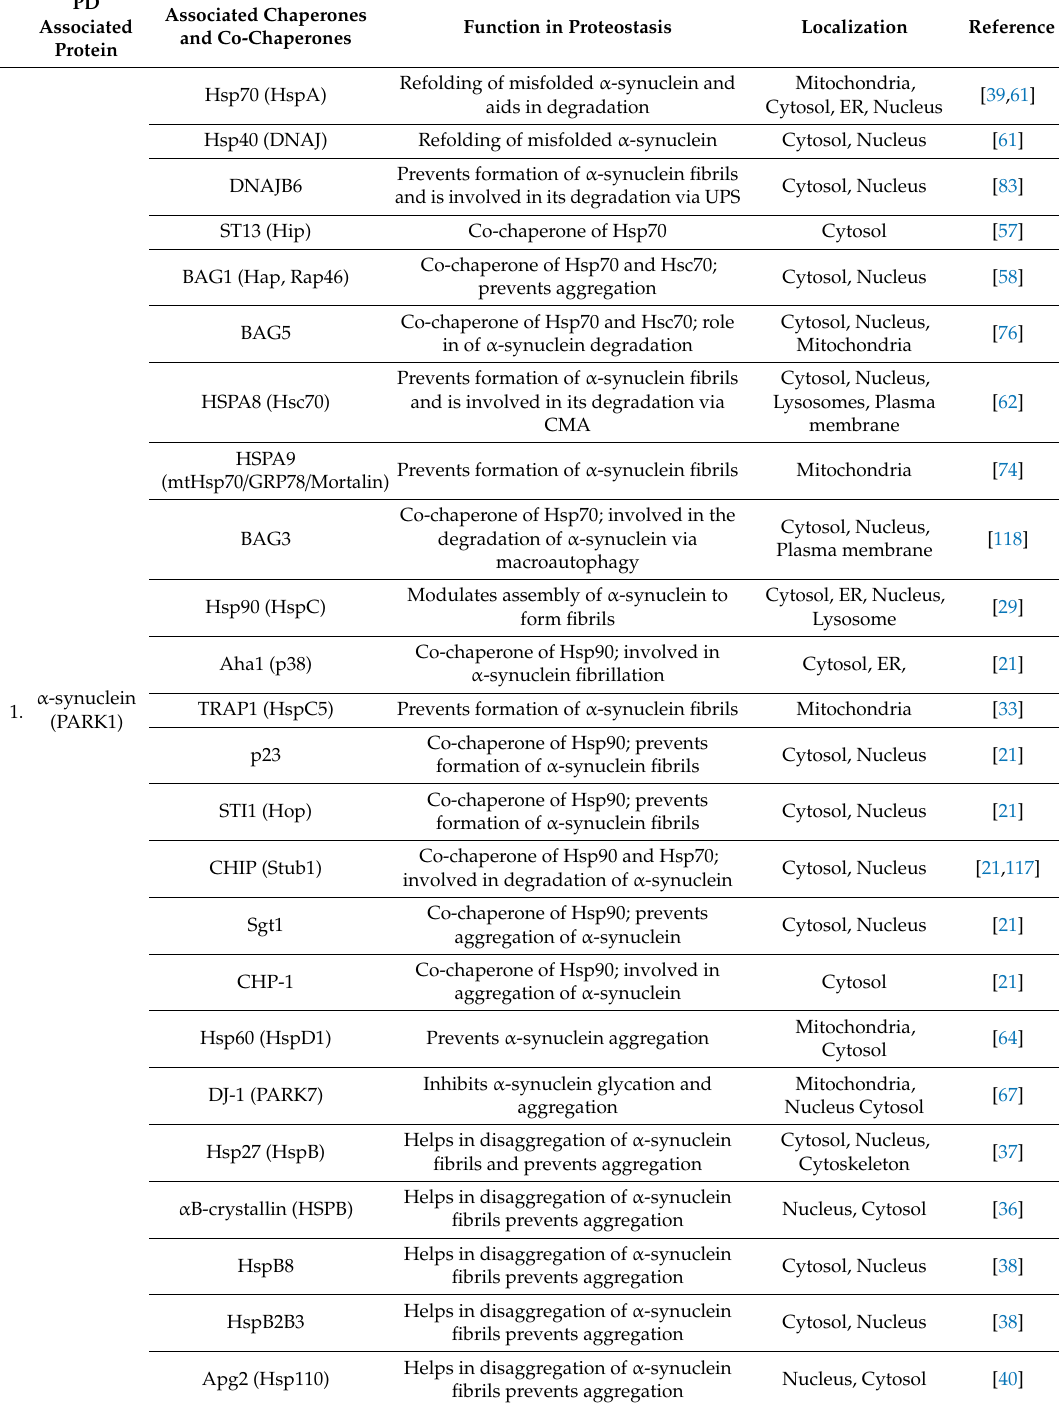
Table 1. Chaperones identified to date that regulate proteostasis of PD-related proteins: The table gives details regarding the cellular localization of the chaperones / co-chaperones and their function in proteostasis of PD related proteins. ER—Endoplasmic Reticulum, UPS—Ubiquitin Proteasome system, and CMA—Chaperone-Mediated